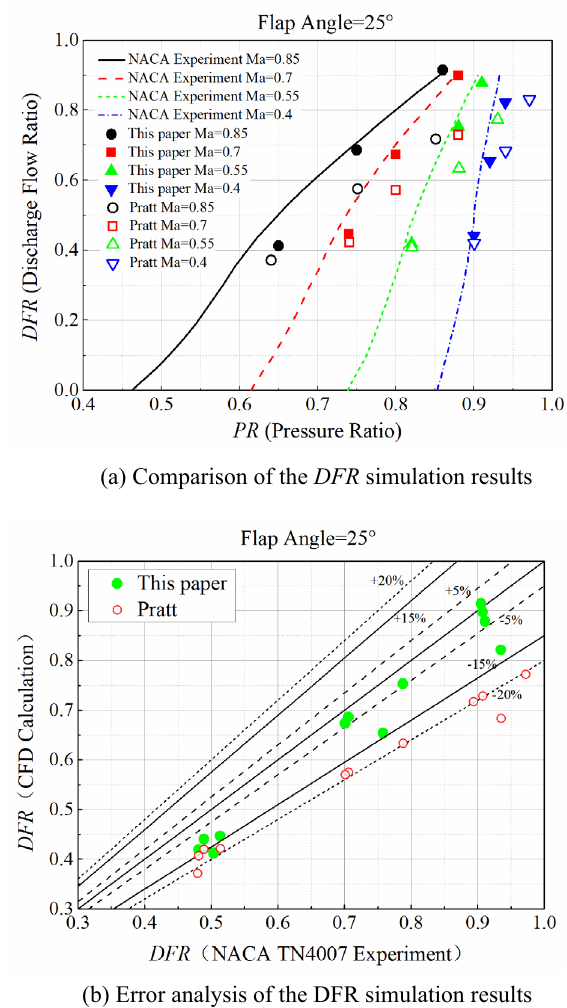
Figure 10. Comparison and error analysis of the simulation results and experimental data for